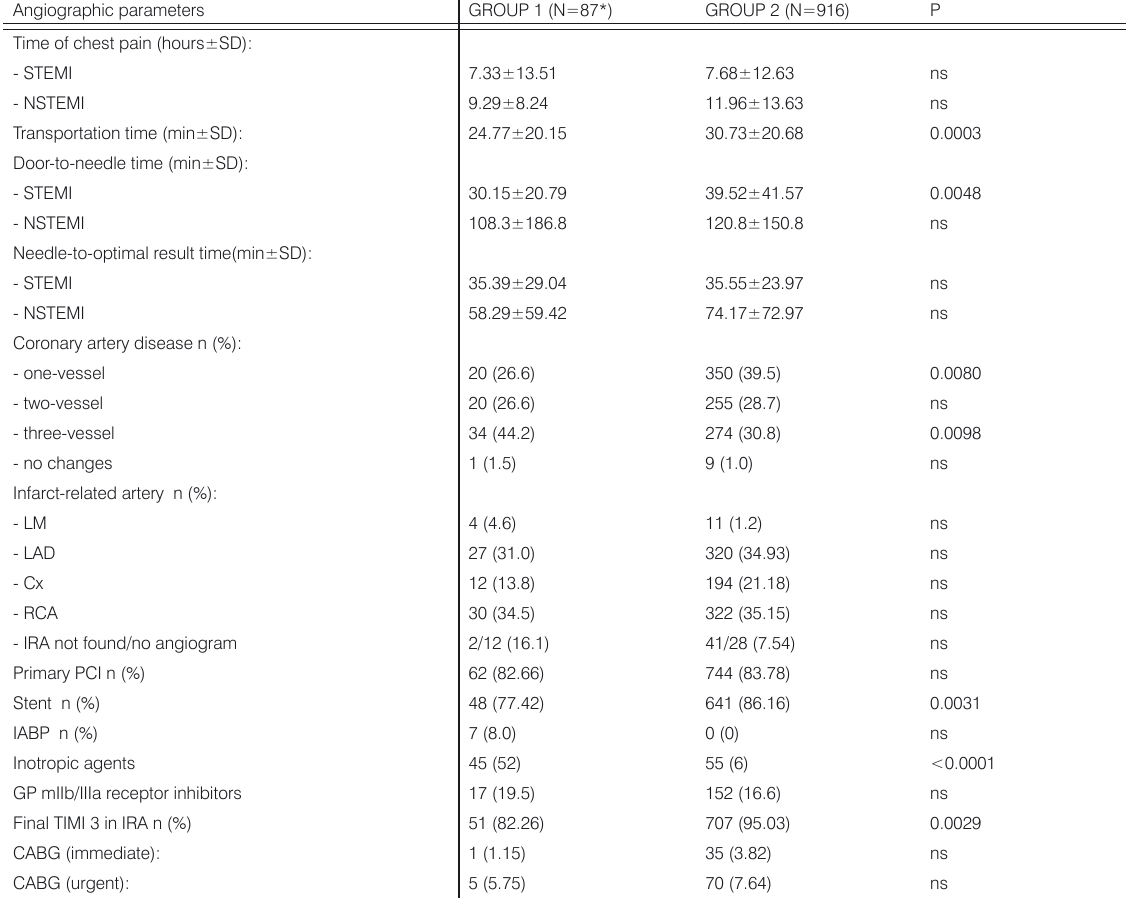
Table 3. Angiographic characteristics.